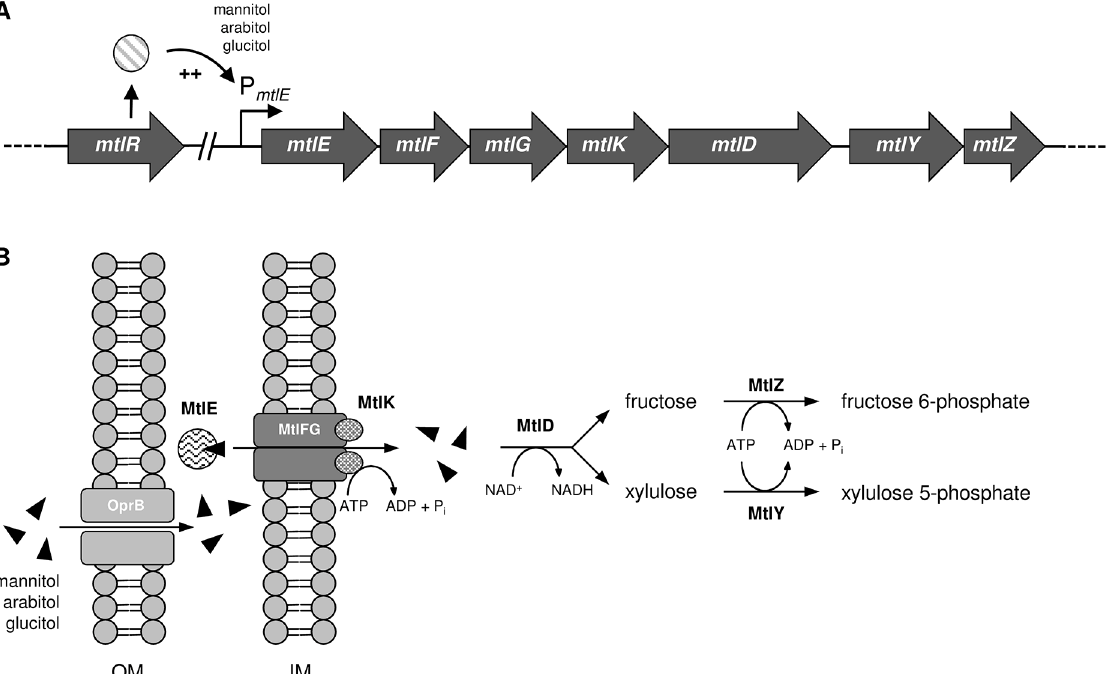
Fig 1. Mannitol, arabitol and glucitol utilization by Pseudomonas fluorescens DSM10506. (A) Structure of the mannitol operon. In the presence of mannitol, arabitol, or glucitol, transcription of mtlE-Z is activated by MtlR. mtlR is located apart from the other genes in the genome of P . fluorescens DSM10506. (B) Mannitol, arabitol and glucitol are translocated into the periplasm likely by outer membrane porin OprB. MtlE (periplasmatic binding protein), MtlFG (transmembrane domains) and MtlK (ATP binding cassette domain) mediate specific transport of the polyols into the cytoplasm where they are oxidized by MtlD (mannitol 1-dehydrogenase). The products fructose (produced from mannitol and glucitol) and xylulose (produced from arabitol) are phosphorylated by MtlZ (fructose kinase) and MtlY (xylulose kinase) and thus trapped inside the cell. OM = outer membrane, IM = inner membrane.